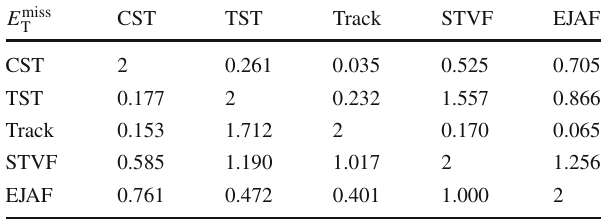
Table 5 Vector correlation coefficients are shown between E miss initions in Z → μμ MC simulation. Below the diagonal are events in the 0-jet sample, and above the diagonal are inclusive events